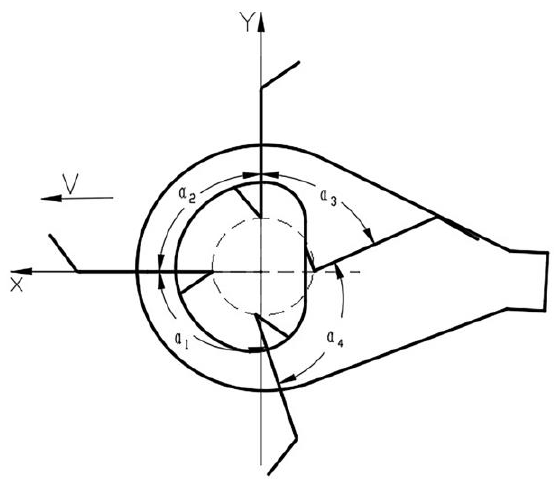
Figure 5. Phase diagram of the picking